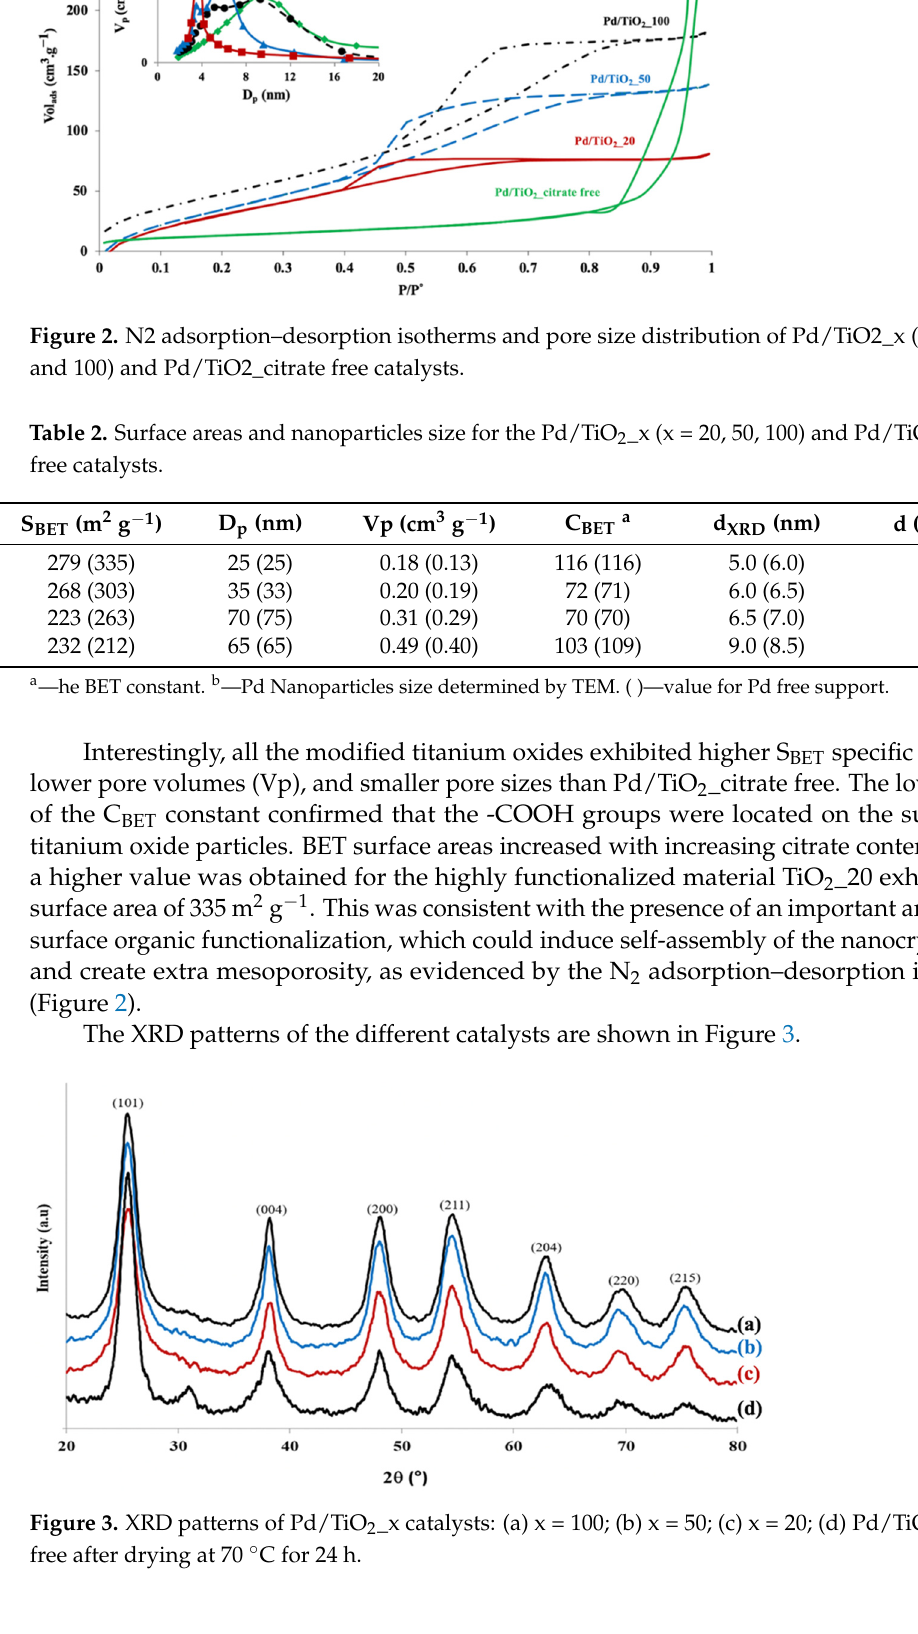
Figure 4. Pd 3d XPS Spectra of Pd/TiO 2 _x: ( a ) x = 20; ( b ) =50, and ( c ) =100 after drying at 70 °C for 24 h.